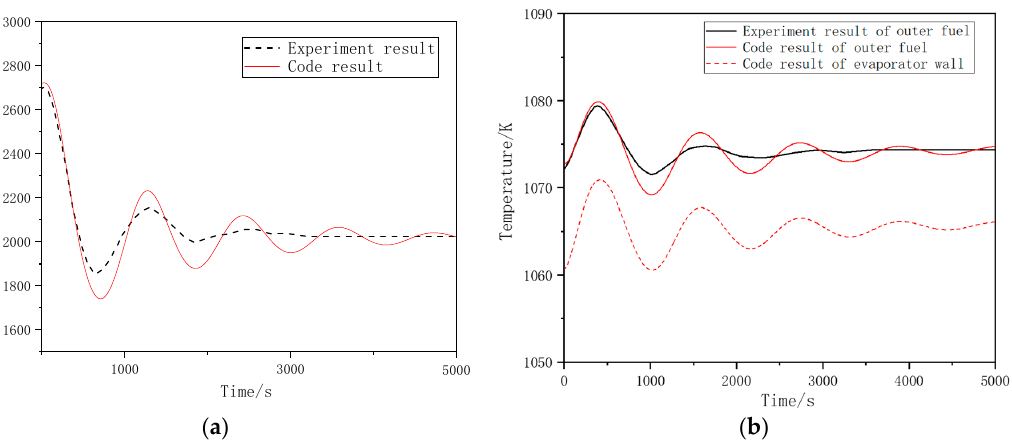
Figure 16. Core power and temperature variation under load decreasing condition: ( a ) core power and ( b ) core temperature.